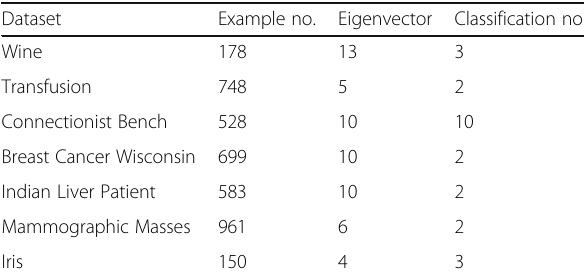
Table 4 UCI dataset used in the experiment Dataset